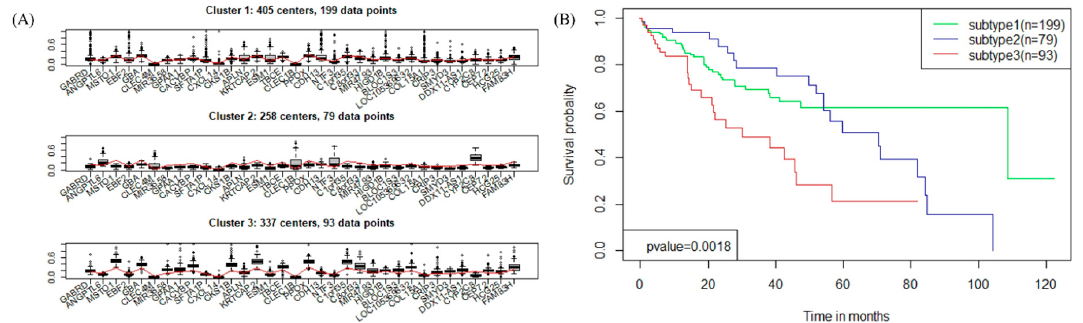
Figure 6. The three subtypes of LIHC. ( A ) Boxplots showing the expression level of the 34 DEGs in three subtypes. ( B ) Survival curves for three subtypes of LIHC in the TCGA